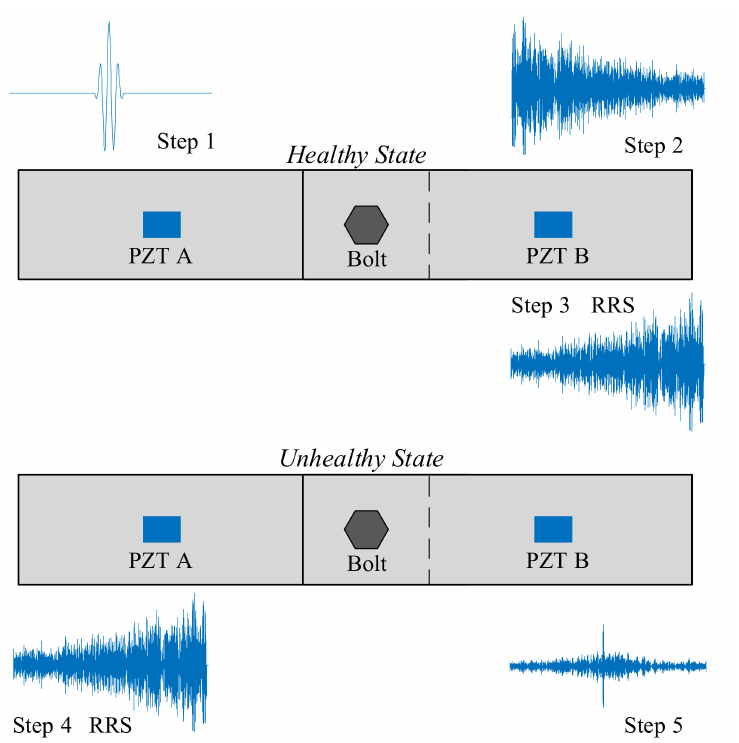
Figure 2. The procedure of the preload monitoring of a bolt lap joint using the VTR